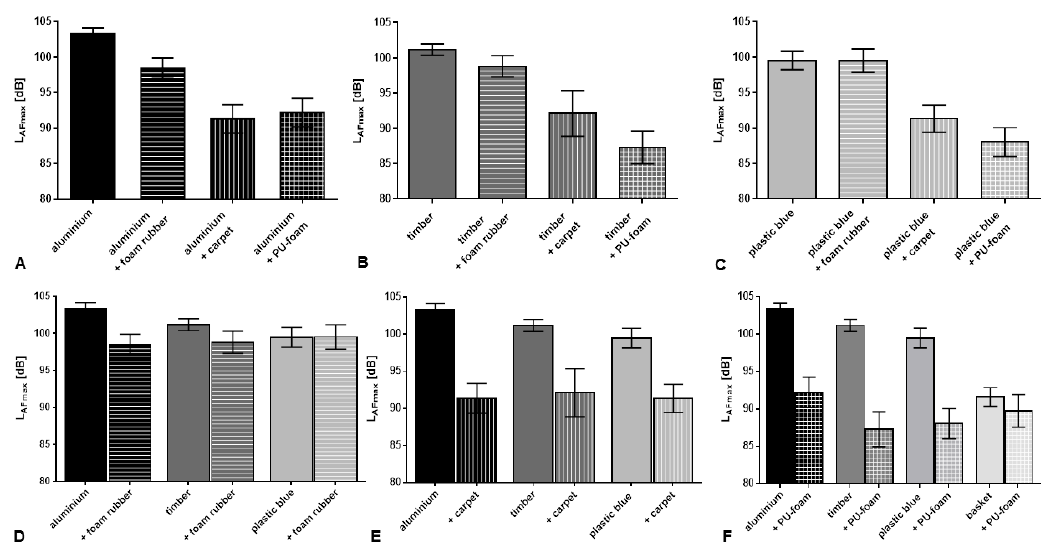
Figure 4. LEGO Duplo toy brick dropping noise level (L AFmax ) measured in different storage cases. ( A ) “aluminium”; ( B ) “timber”; and ( C ) “plastic blue”, with different insert damping materials; lower row: as ( A )–( C ), but arranged to compare the efficacy of different insert damping materials ( D ) foam rubber; ( E ) carpet; and ( F ) PU foam.